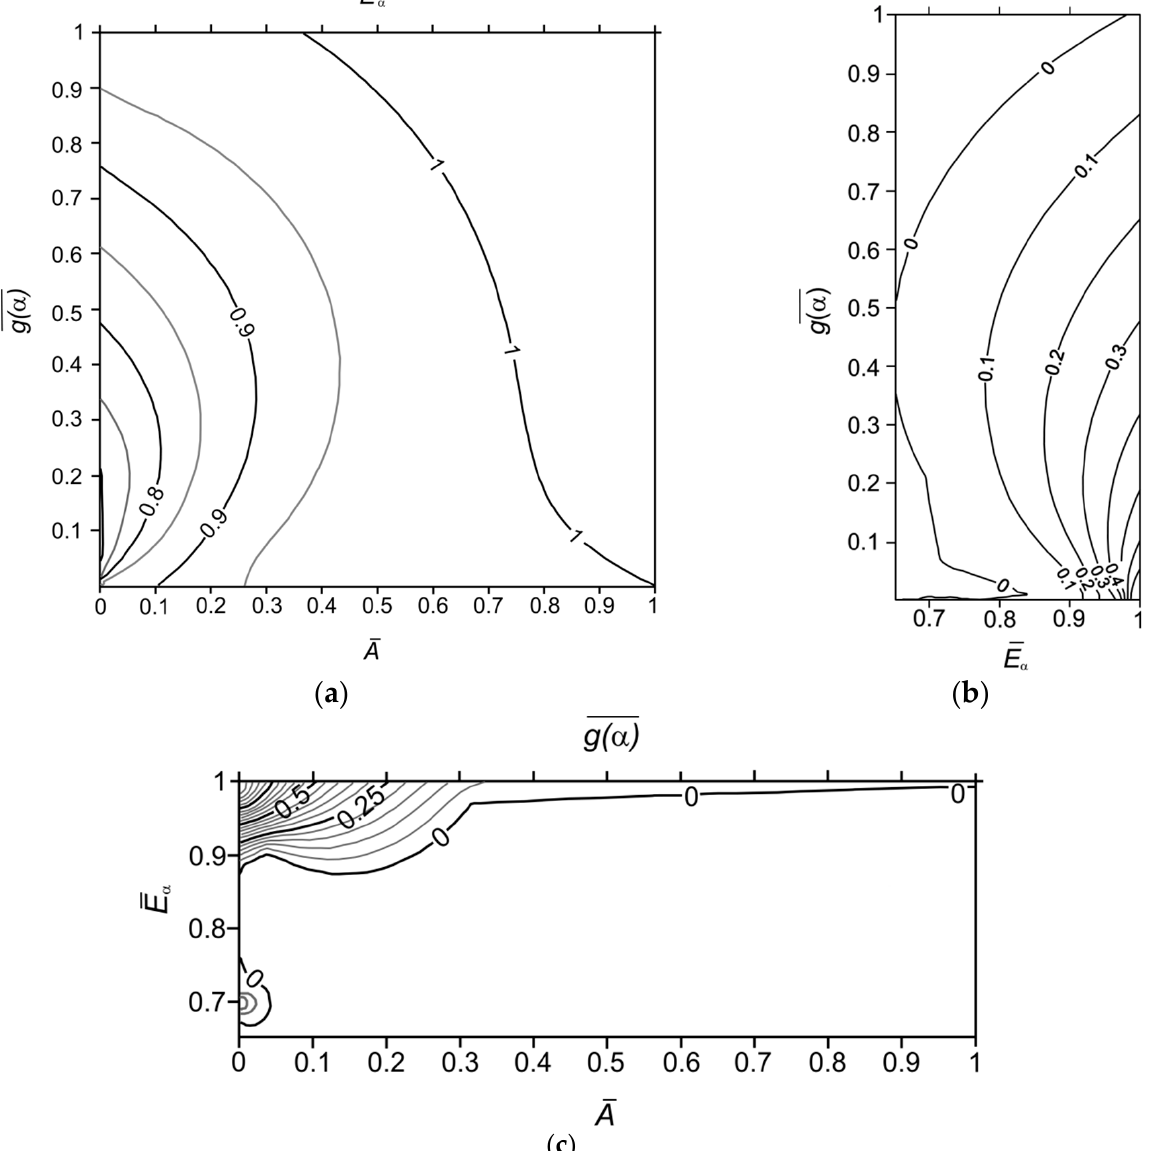
Figure 7. Projections of the surface: ( a ) activation energy; ( b ) pre-exponential factor; ( c ) algebraic g( α ) function.